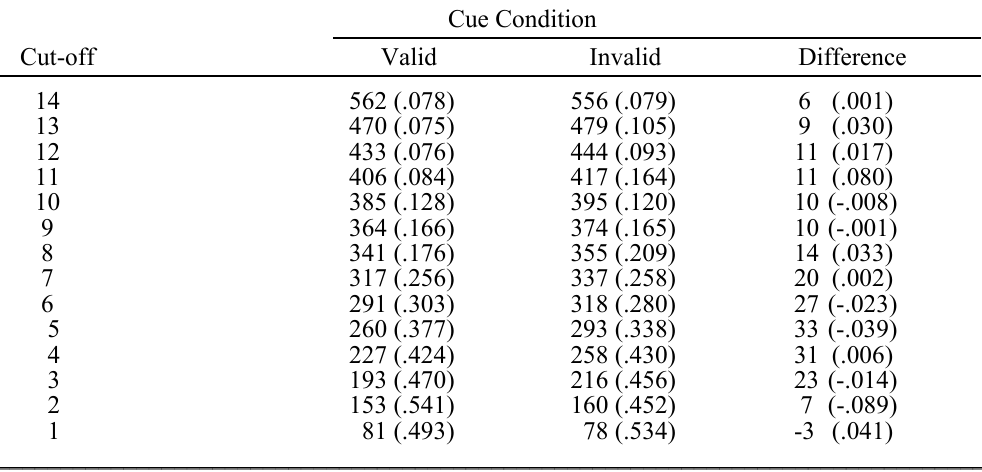
Mean Response Times (ms) and Error Rates (in Brackets) Across Equal-Sized Intervals of the Ranked RT Data in Experiment 2 (Each Cell Contains 100 Trials)